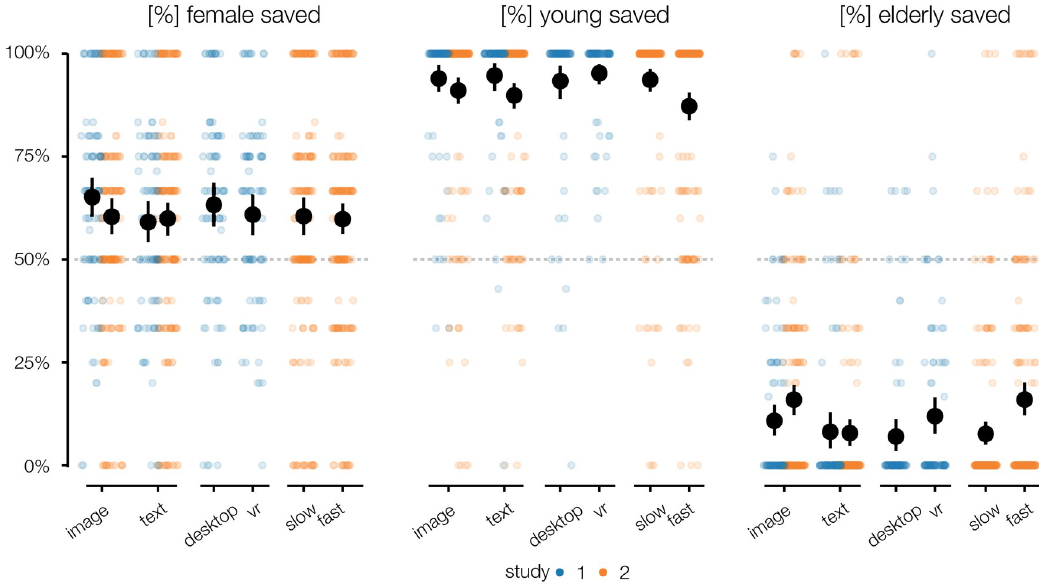
Fig 2. Saving rates. Rates of saving young (left), male (middle) and elderly (right) people, by study and experimental condition.